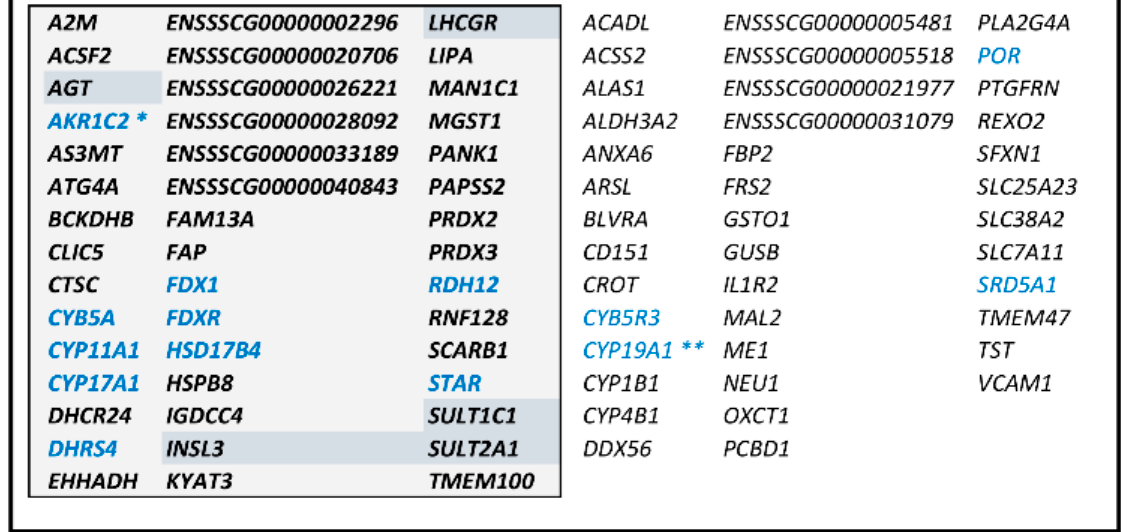
Figure 6. Presentation of CYP11A1-group (85 genes). The 45 genes presented in the shaded box constitute the core group. Their expression are highly correlated to that of CYP11A1 in both datasets (mRNAseq-P and -PLW). The other 40 genes are strongly correlated to CYP11A1 in only one dataset. All genes cited in Appendix A are indicated in blue. Genes that are indicated with a grey-blue background are genes cited in this study. * In mRNAseq analysis, the RSEM pipeline attributed to this gene counts of all AKR1C genes that have different known specificities. Nevertheless, RT-qPCR results (Figure 1) showed that the gene involved in testicular steroid synthesis is AKR1C4 . ** In mRNAseq analysis, the RSEM counts attributed to this gene include counts of the three CYP19A genes.